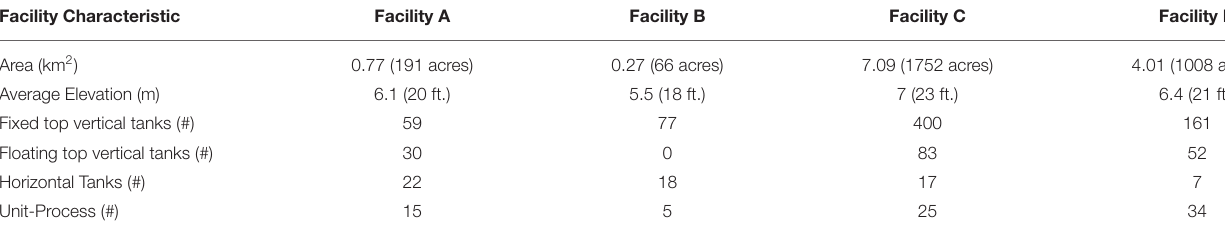
TABLE 3 | Facility characteristics for the modeled Case Study facilities in the HSC.